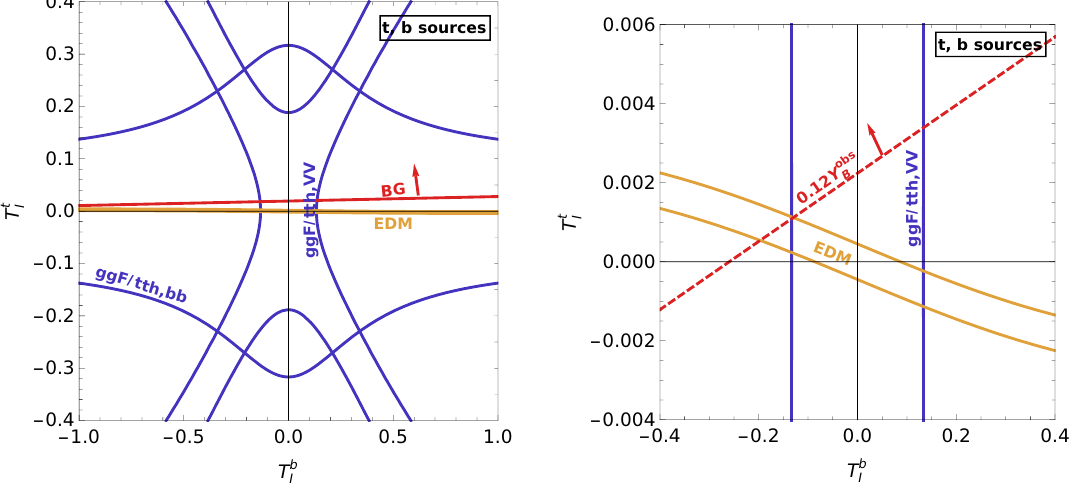
Figure 5 . Constraints on t and b sources with T t;b = 0 from the LHC (blue), the eEDM (yellow) and R Y B (red). Left: full collider range (combining ATLAS and CMS) allowed by (cid:22) bb = 0 : 88 (cid:6) 0 : 43 tth + ggF and (cid:22) V V = 1 : 08 (cid:6) 0 : 08, right: zoomed into the EDM-allowed ggF + tth + th